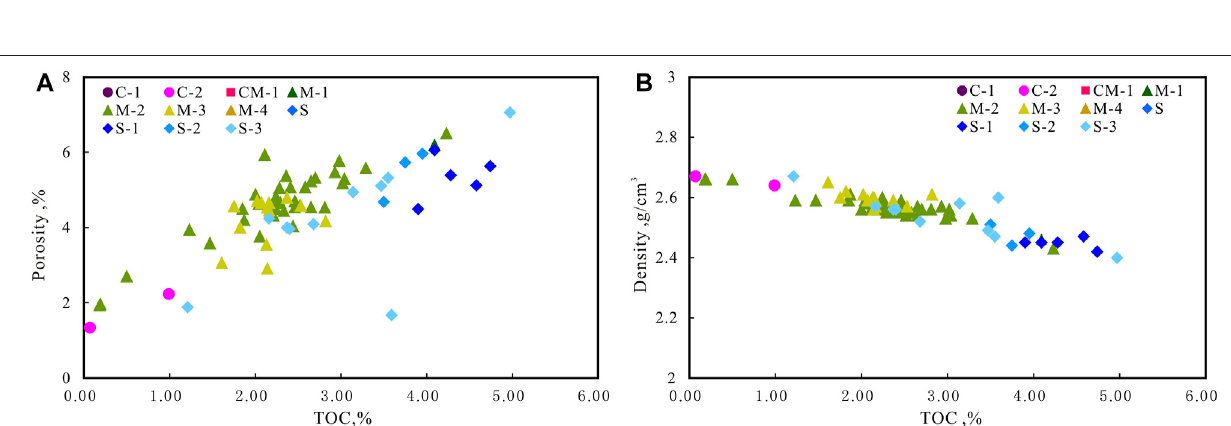
Frontiers in Earth Science |